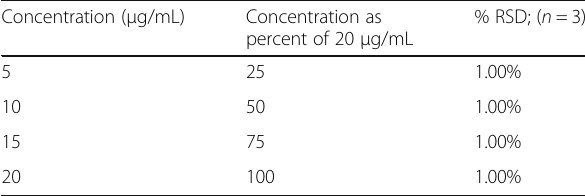
Table 2 System precision results (% RSD) of triplicate sample application of single sample dilution for chlorpyrifos Concentration ( μ g/mL)